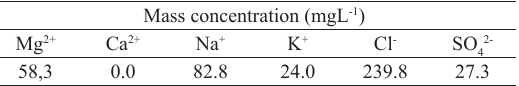
Table 1. Mass concentration of ions in the HSW samples before treatment. Mass concentration (mgL -1